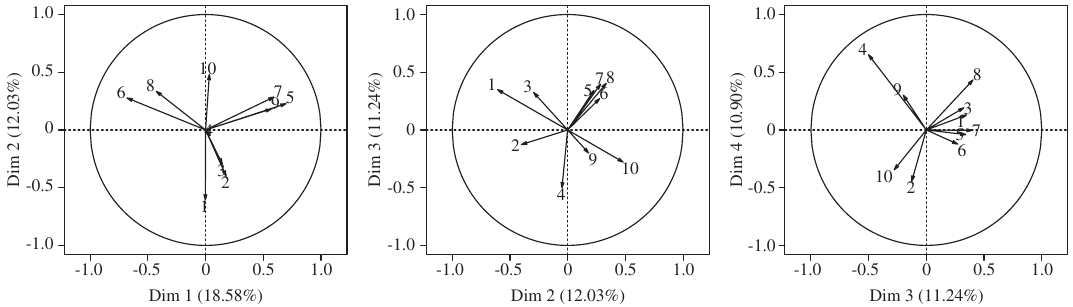
Figure 11. Coefficient Circles of Multipeaked Class.